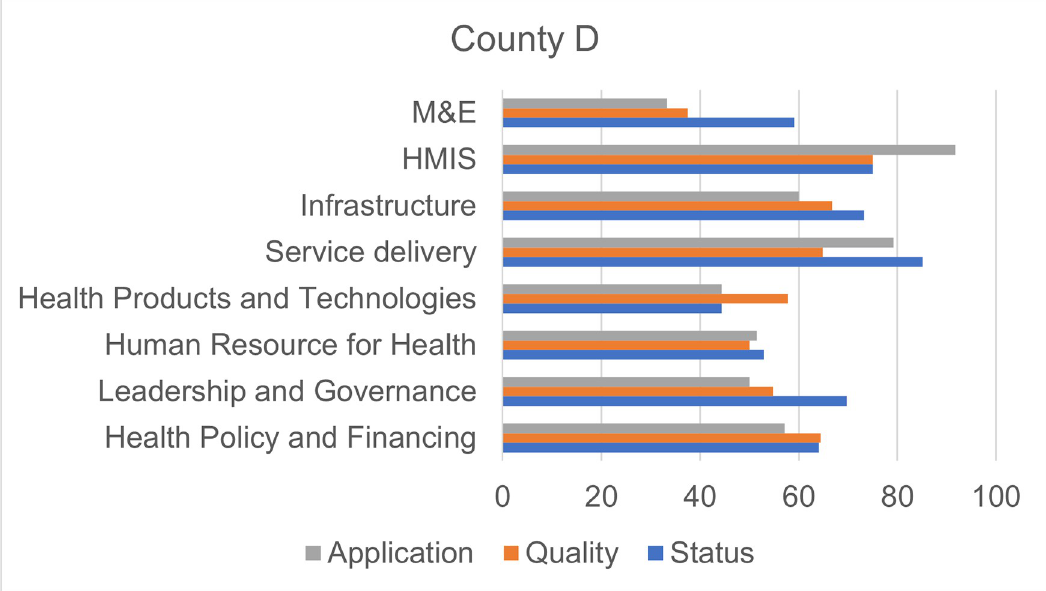
Fig 4. Scores by dimension of assessment, County